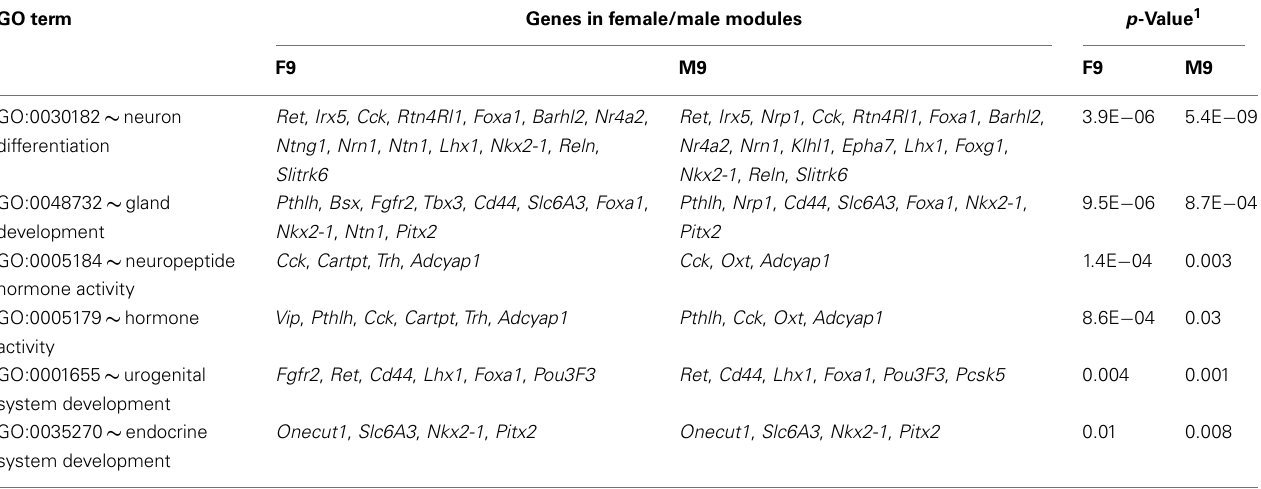
Table 3 | Concordant enriched gene functions in the female F9 and male M9 modules.